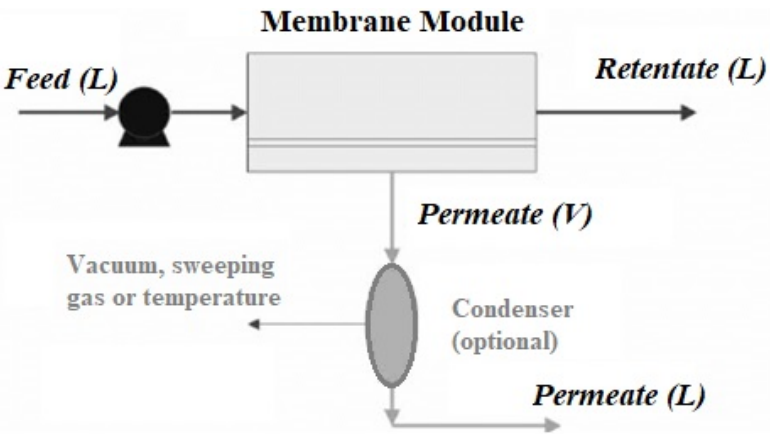
Figure 11. General schematic of a pervaporation process. Reproduced from Ref. [73]. Copyright 2006 Taylor & Francis Online. Taylor & Francis Online.